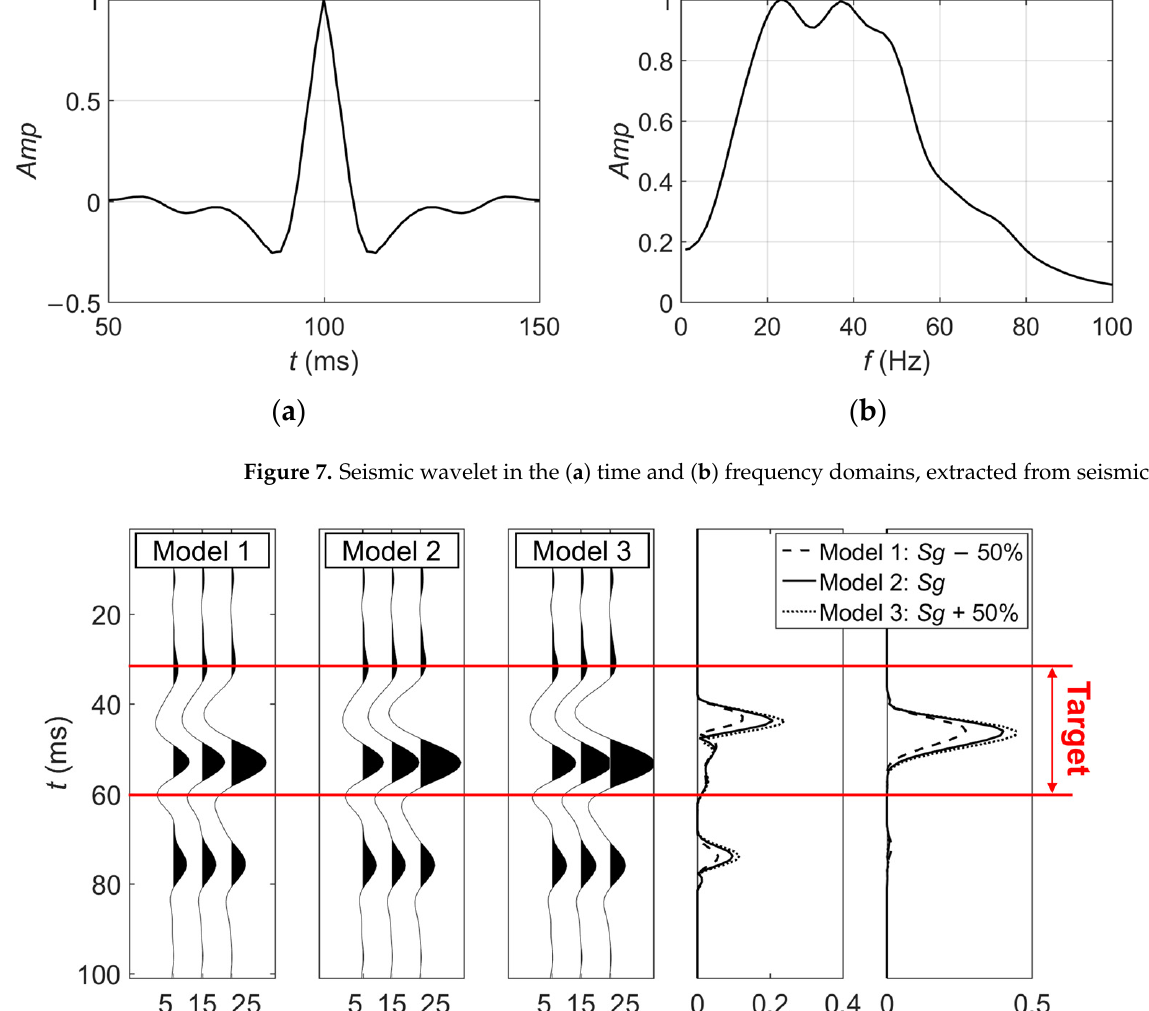
Figure 6. Figure Figure 6.